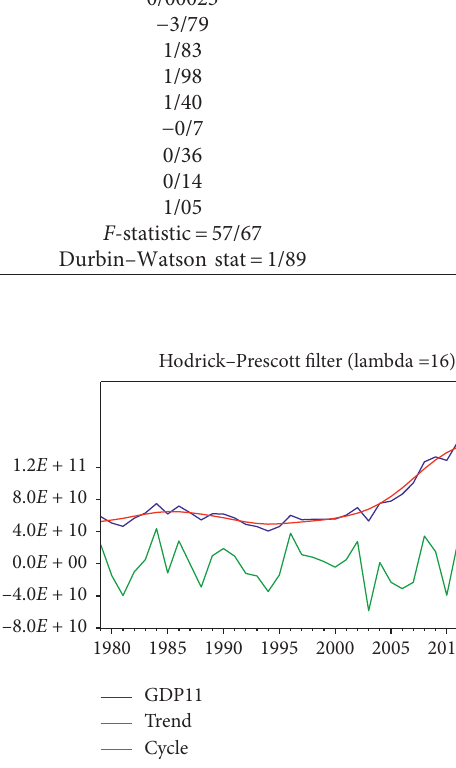
Figure 4: Hodrick–Prescott filter output estimation of two research